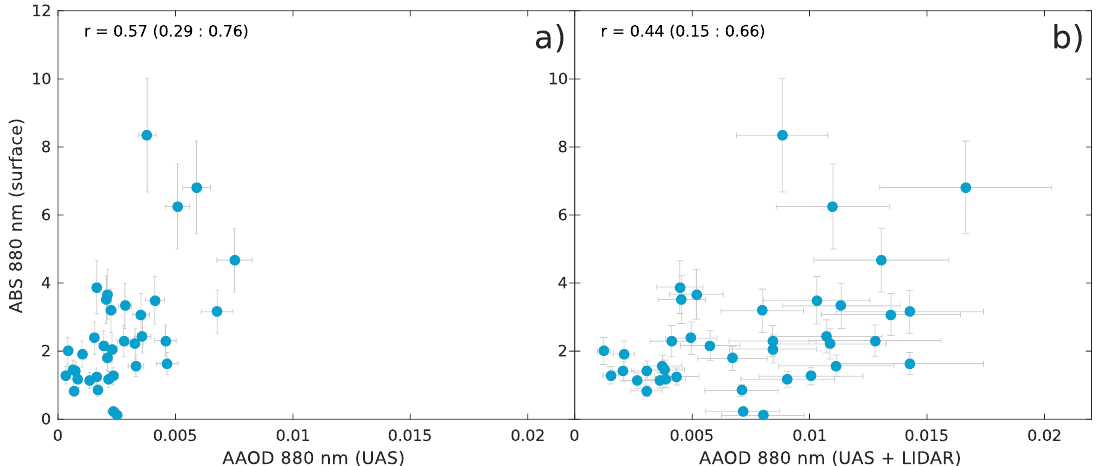
Figure 13. Scatter plot for surface absorption (aethalometer) coefficient at 880 nm and AAOD@880nm estimated from ( a ) UAS profiles and ( b ) UAS profiles extended by lidar measurements in June–August 2015 at SolarAOT site.